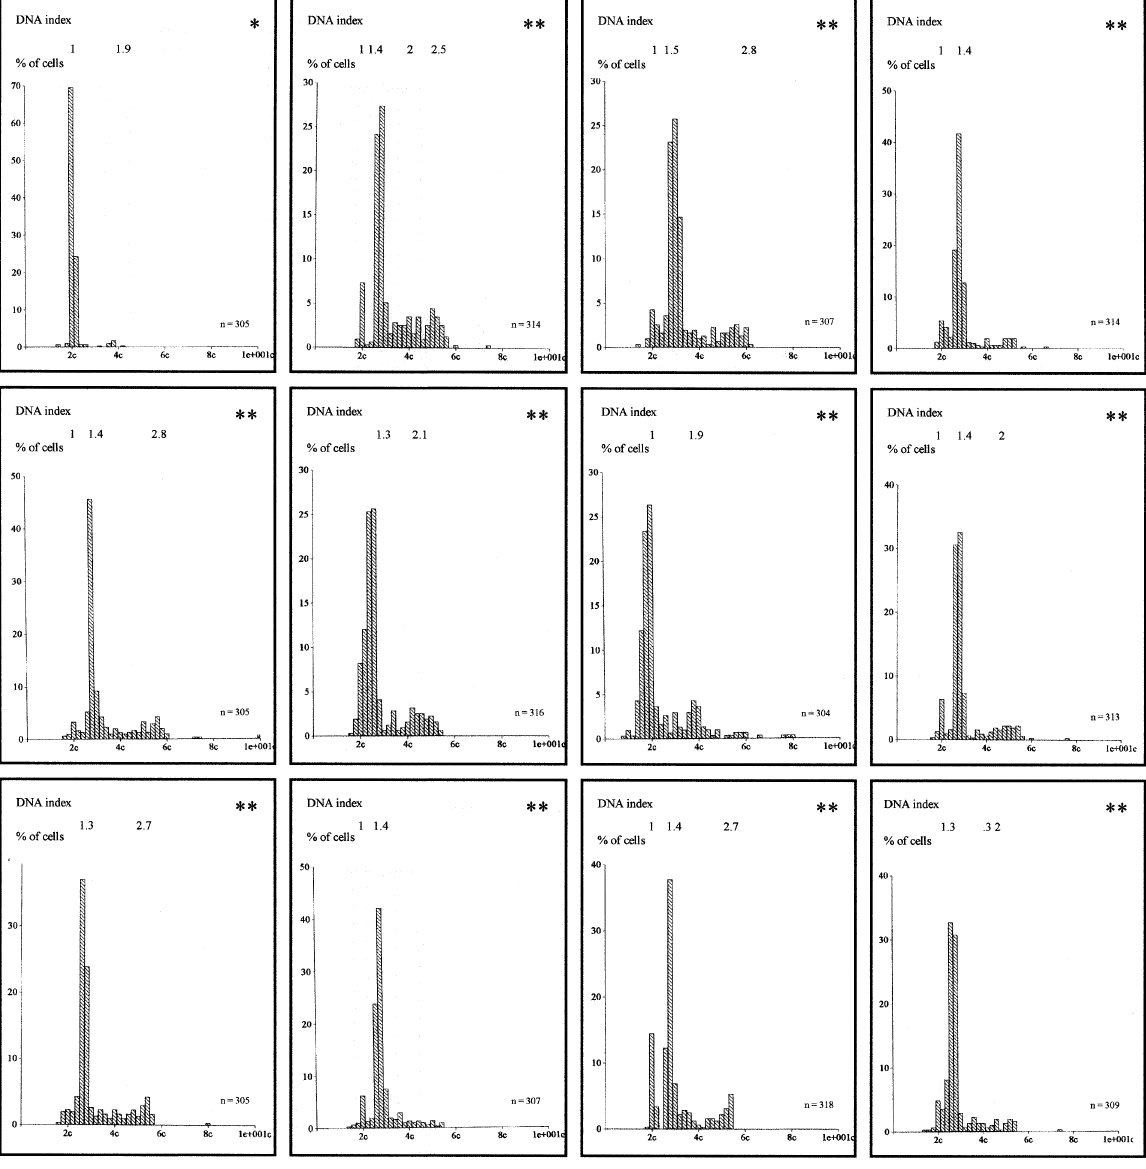
Fig. 4. Histograms illustrating a DNA-ploidy homogeneous gastric carcinoma: ∗ normal mucosa (diploid), ∗∗ tumoral sample (aneuploid). n = number of cells